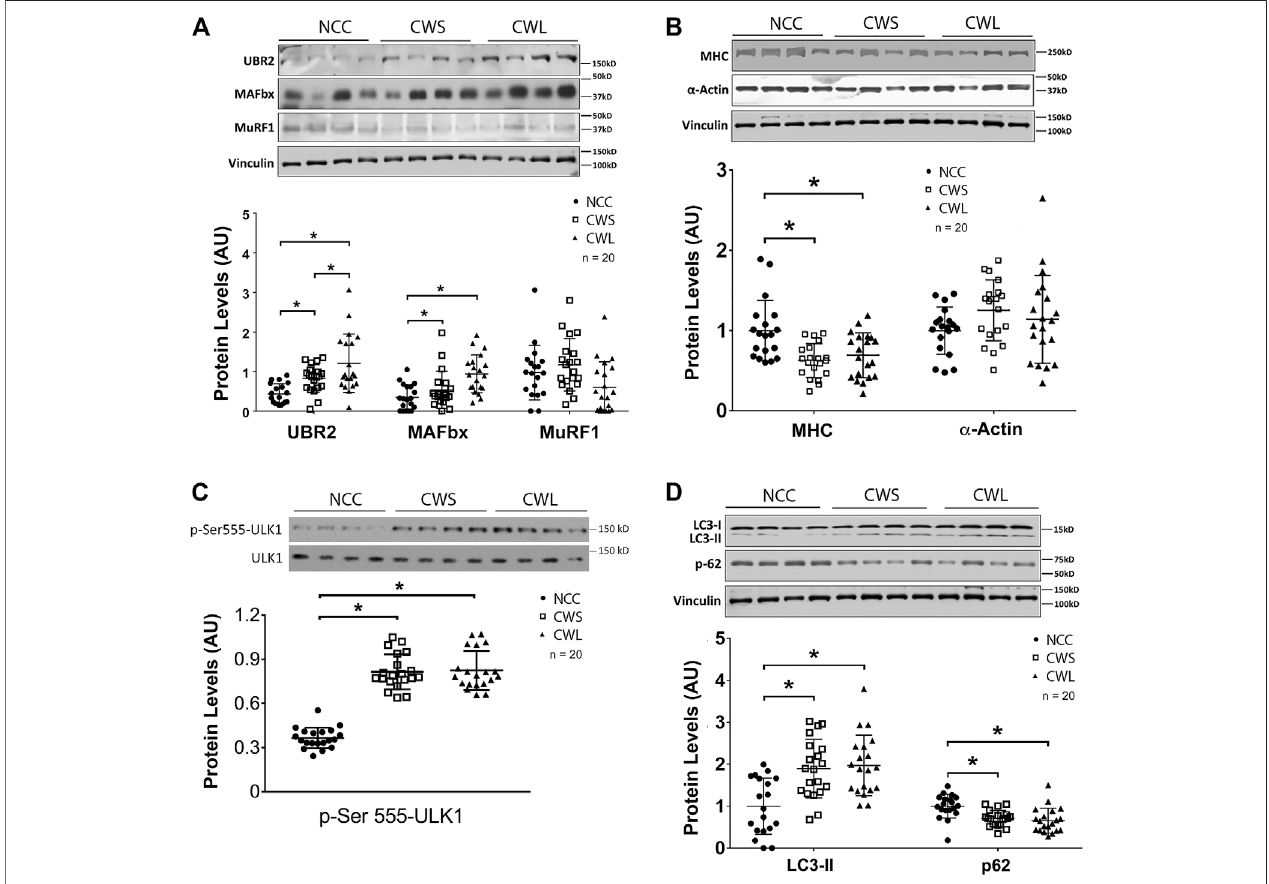
FIGURE 3 | Higher levels of UBR2 and MAFbx as well as active ULK-1 and LC3-II are accompanied by lower myosin heavy chain and p62 levels in RA of cancer patients. (A) TheproteinlevelsofUBR2,atrogin1/MAFbxandMuRF1weredeterminedbyWesternblotanalysis. (B) Levelsofmyo fi brillarproteinsMHCand α -actinwere determined by Western blot analysis. (C) Active ULK1 was determined by Western blot analysis of its phosphorylation of Ser-555 residue. (D) Autophagy activity was determined by Western blot analysis of LC3 and p62. Data were analyzed by one-way ANOVA combined with Tukey ’ s test. * denotes p < 0.05.